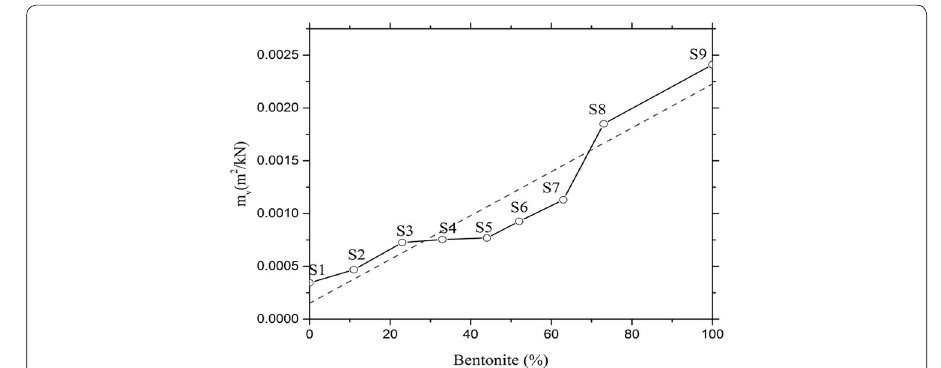
Fig. 9 Influence of bentonite content on the compressibility of